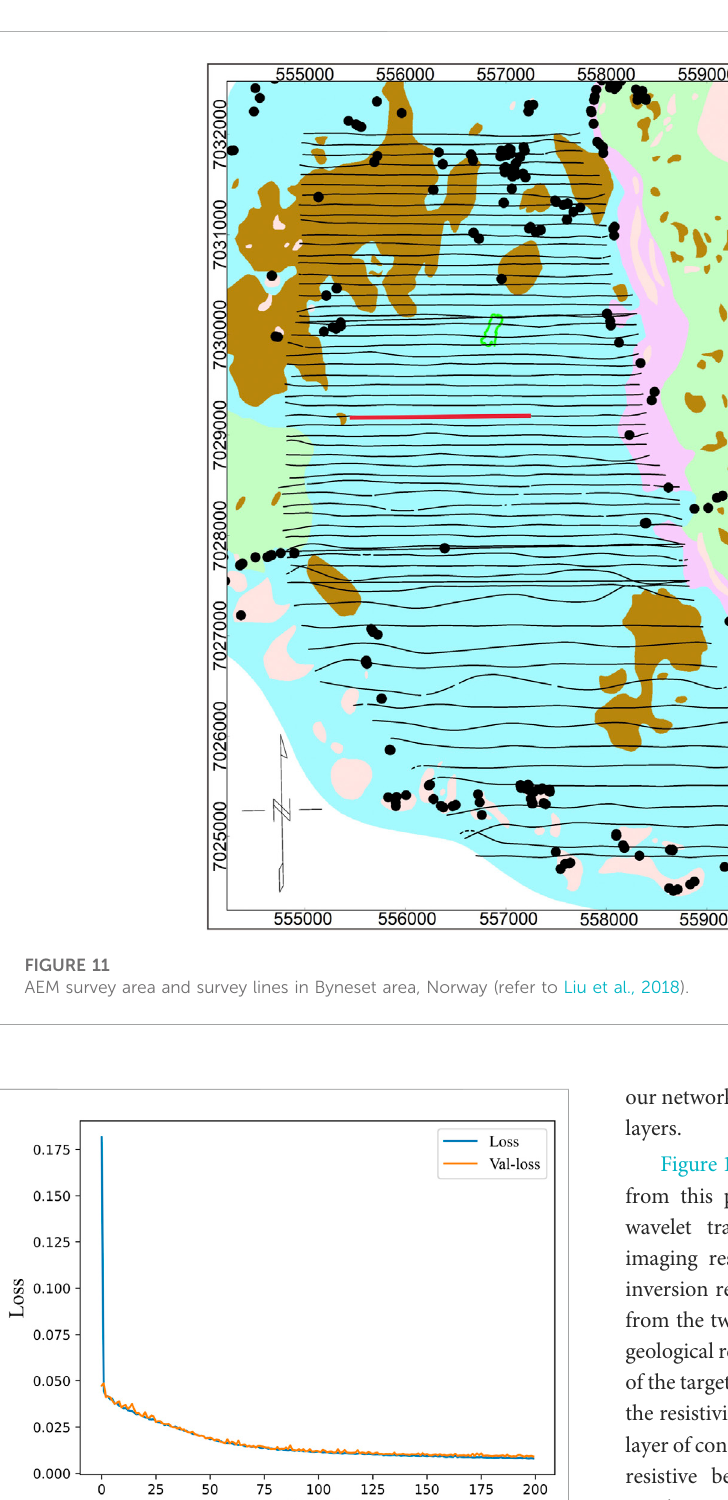
Loss versus epoch for the training set used to image the fi eld survey data.